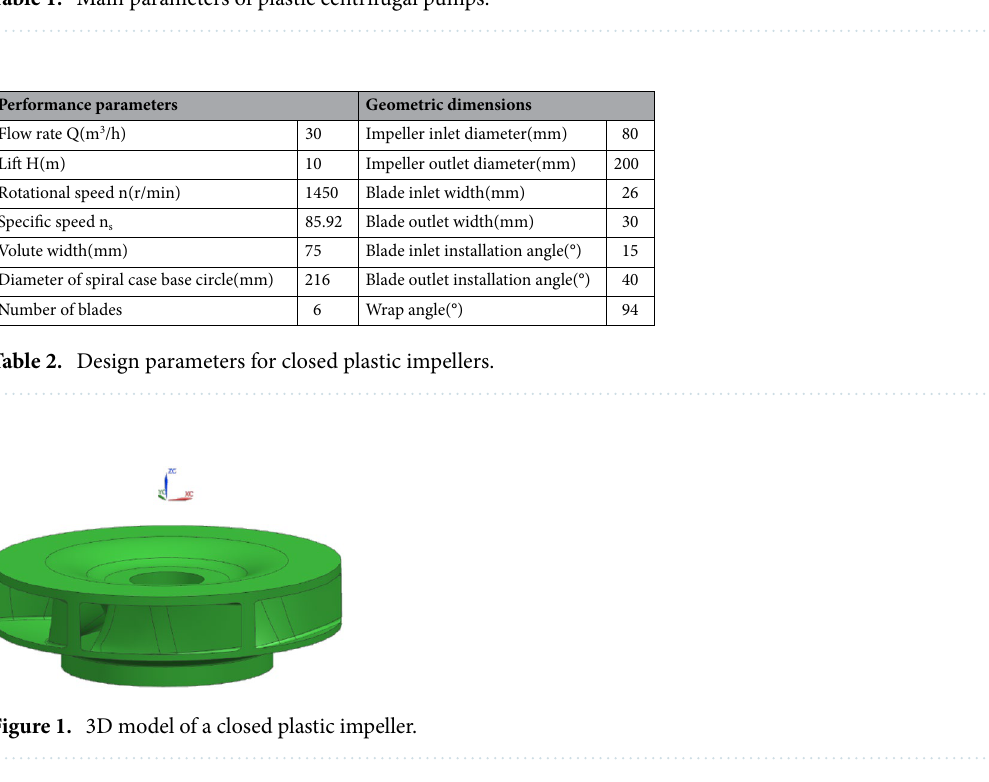
Table 1. Main parameters of plastic centrifugal pumps.